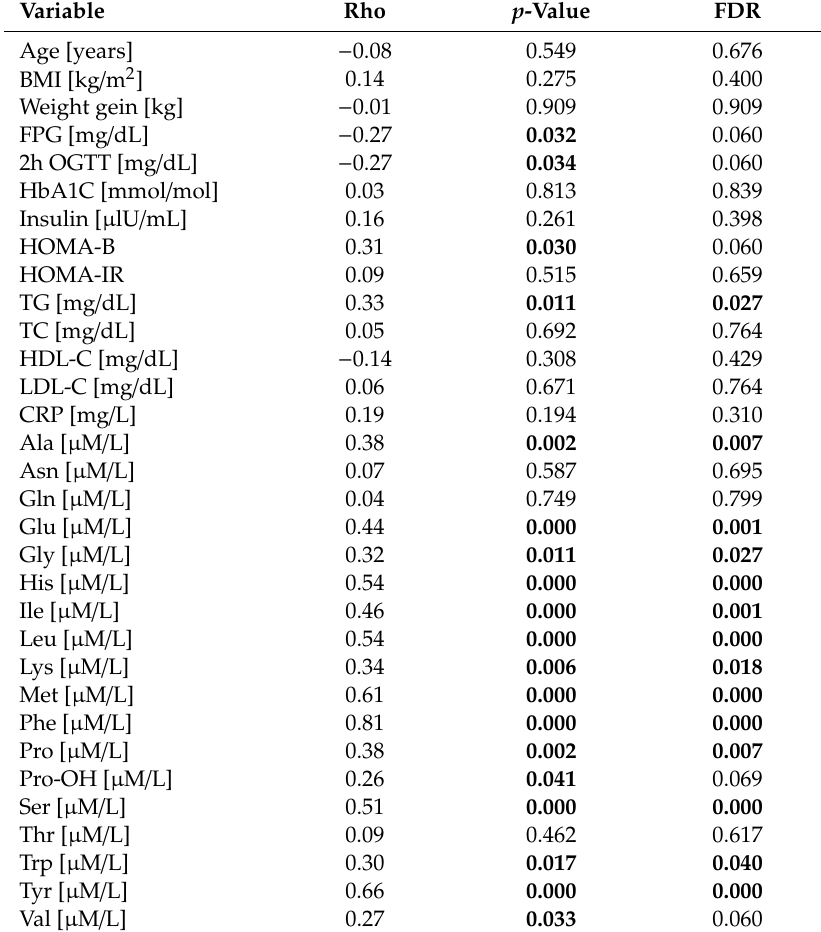
Abbreviations: see Table 2. Values in bold are statistically